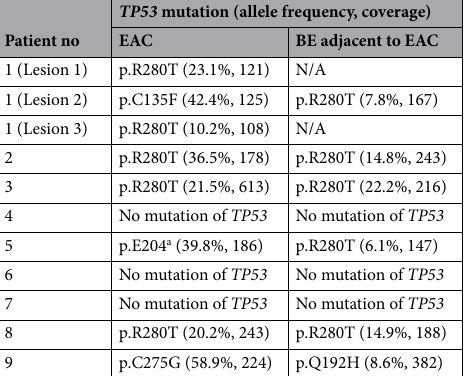
Table 4. Putative drivers of TP53 in patients with esophageal adenocarcinoma. BE Barrett’s esophagus, EAC esophageal adenocarcinoma, N/A not applicable. a Stop